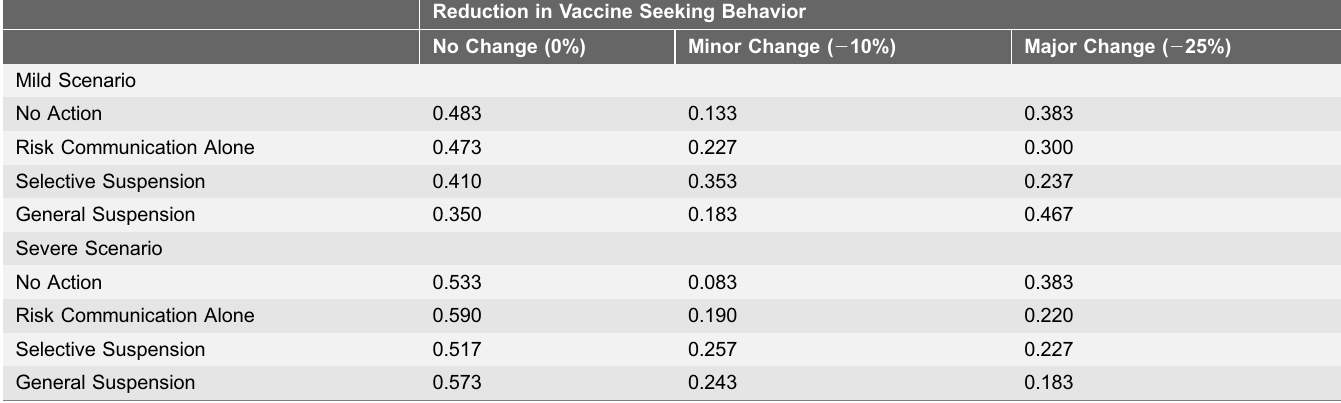
Table 2. Anticipated Changes in Vaccine-Seeking Behavior associated with Four Regulatory Responses.